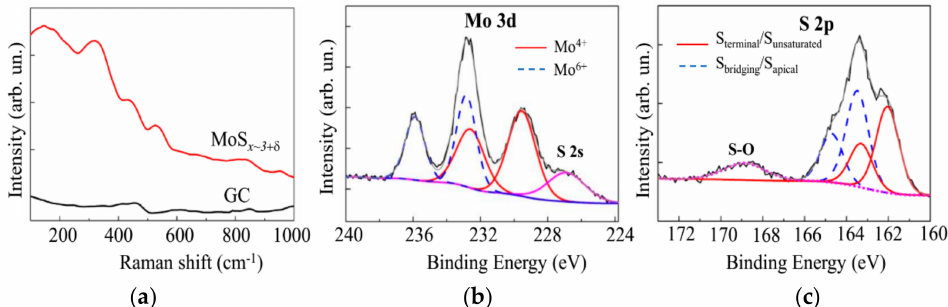
Figure 10. ( a ) Raman spectra for the GC substrate, with and without the MoS x ~3 + δ thin film catalyst obtained by o ff -axis PLD. ( b,c ) XPS spectra of Mo 3d and S 2p, respectively, measured on the surface of the MoS x ~3 + δ catalyst after prolonged exposure in the